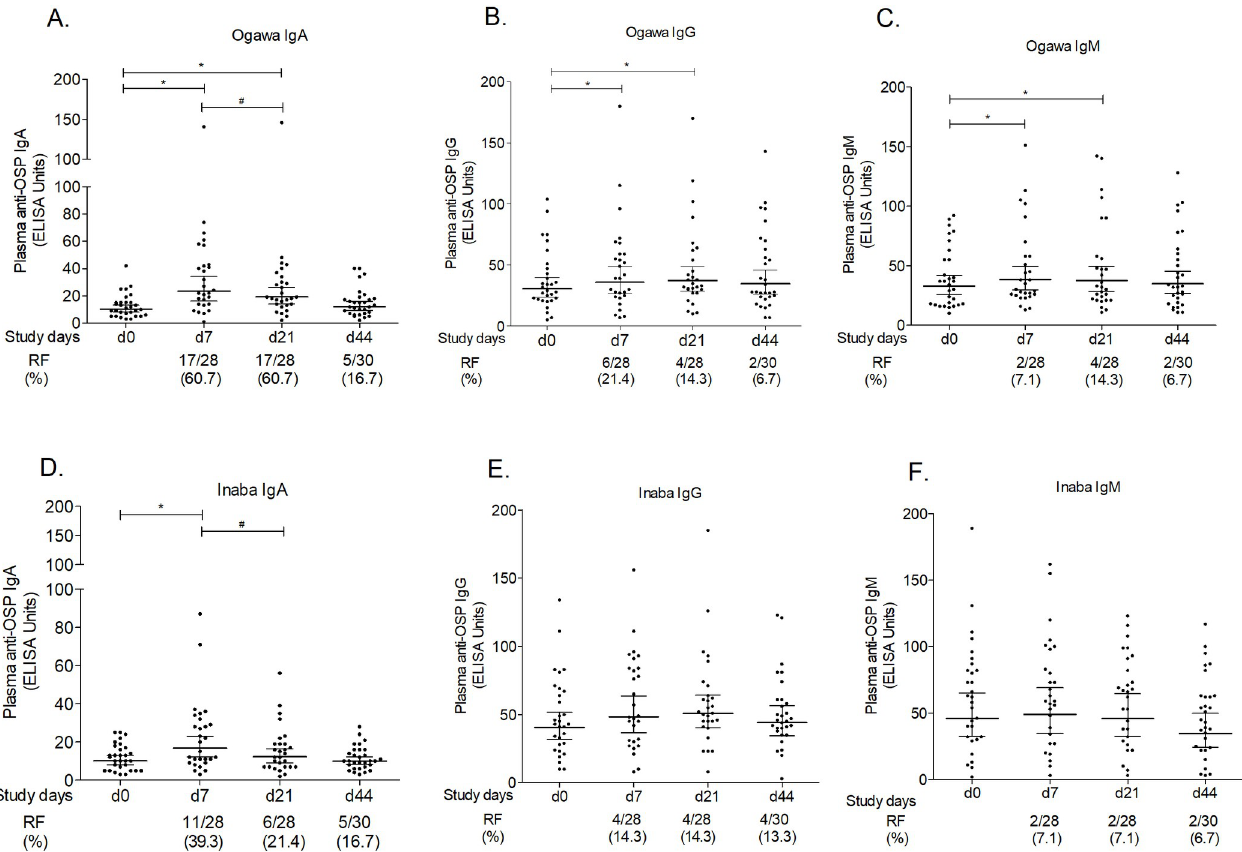
Fig 2. Plasma OSP-specific IgA, IgG and IgM responses. (A) Immunoglobulin A (IgA), (B) IgG, and (C) IgM responses to Ogawa OSP, and (D) IgA, (E) IgG, and (F) IgM responses to Inaba OSP are indicated. Each single dot indicates an individual OSP antibody value; horizontal bars represent geometric means (GM) and error bars indicate 95% confidence intervals. The Wilcoxon signed-rank test was used for analyses of the data. Asterisks indicate a statistically significant difference from baseline level (day 0). Responder frequencies (RF) are shown below the x axes. # indicates a statistically significant decrease in plasma antibody titers in vaccinees 7 days after the first and second dose of vaccination (at day 7 and day 21), respectively (P � 0.05).